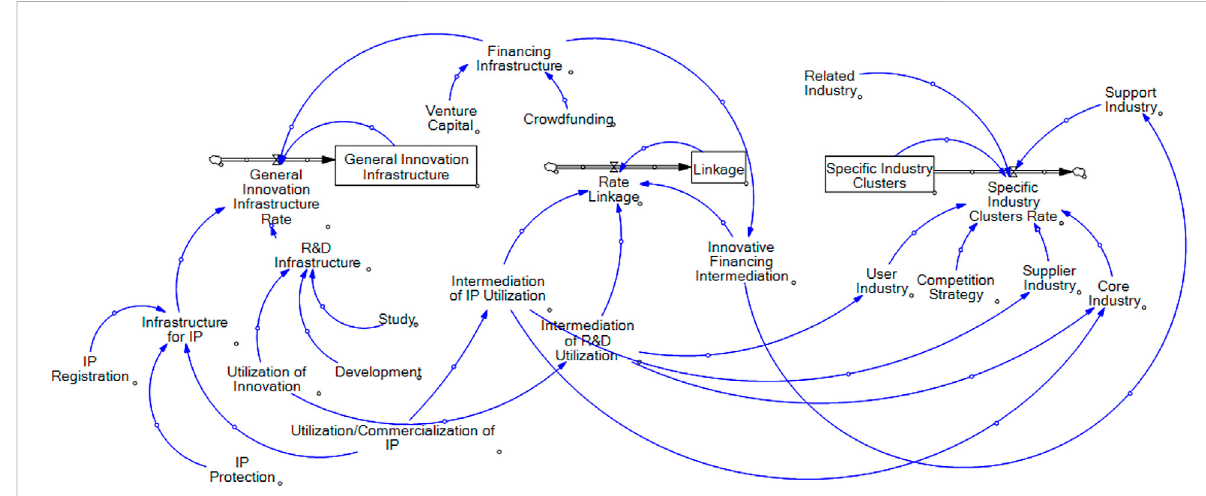
FIGURE 4 Stock fl ow diagram conceptualization source: Data Processing Results, 2022.